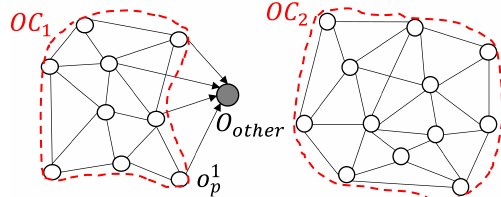
Figure 8. An example of expanding processing. OC 1 and OC 2 are the two object clusters, where o 1 p is the p -th object in OC 1 and O other is an object of another category and separates OC 1 from OC 2 . The expanding uses the spatial-pattern features to determine the ascription of O other